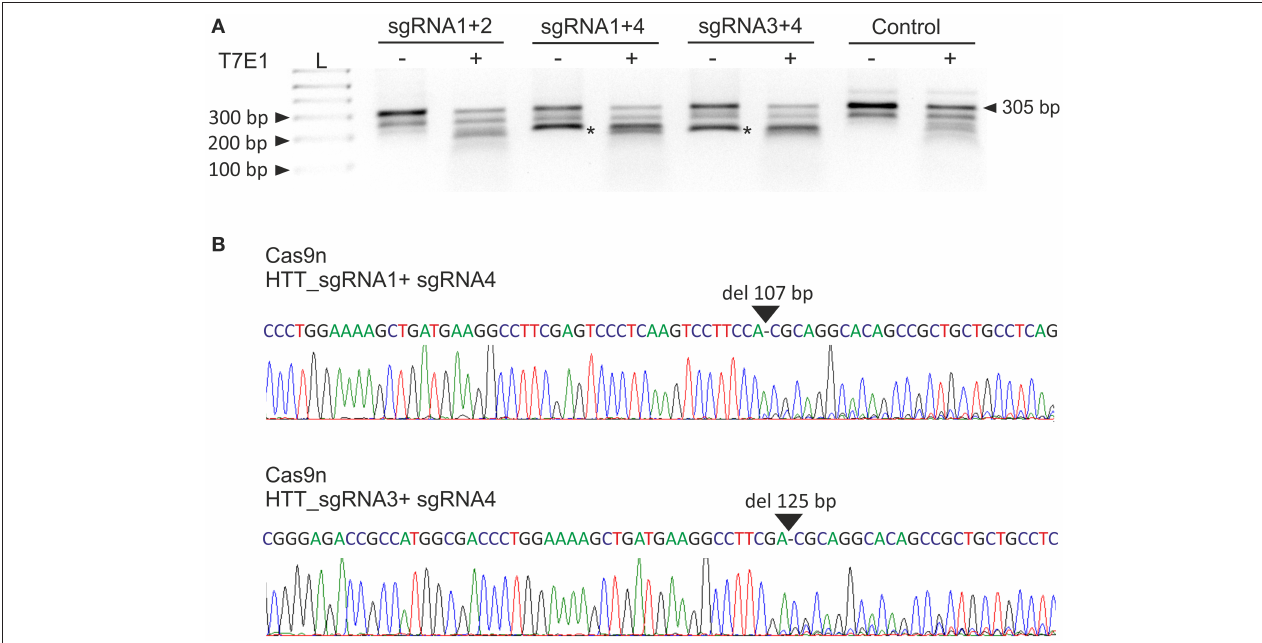
FIGURE 2 | Excision of the CAG repeats from the HTT gene with paired Cas9 nickases. (A) DNA from HEK293T cells treated with Cas9 nickase and the HTT_sgRNA pairs was PCR amplified and subjected to T7E1 analysis. The length of the unmodified PCR fragment is 305 bp, whereas the edited products are shortened to < 200 bp (marked with an asterisk). (B) A representative Sanger sequencing electropherogram showing the deletion of 107 and 125 bp in HTT_sgRNA1 + 4- and HTT_sgRNA1 + 3-treated cells, respectively (marked with an arrow).